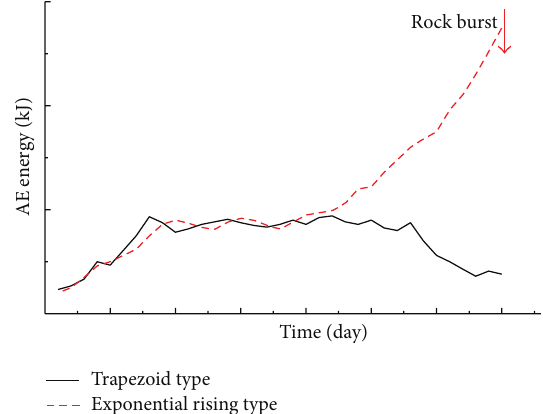
Figure 4: Patterns of AE energy with the closing of the coal face to the